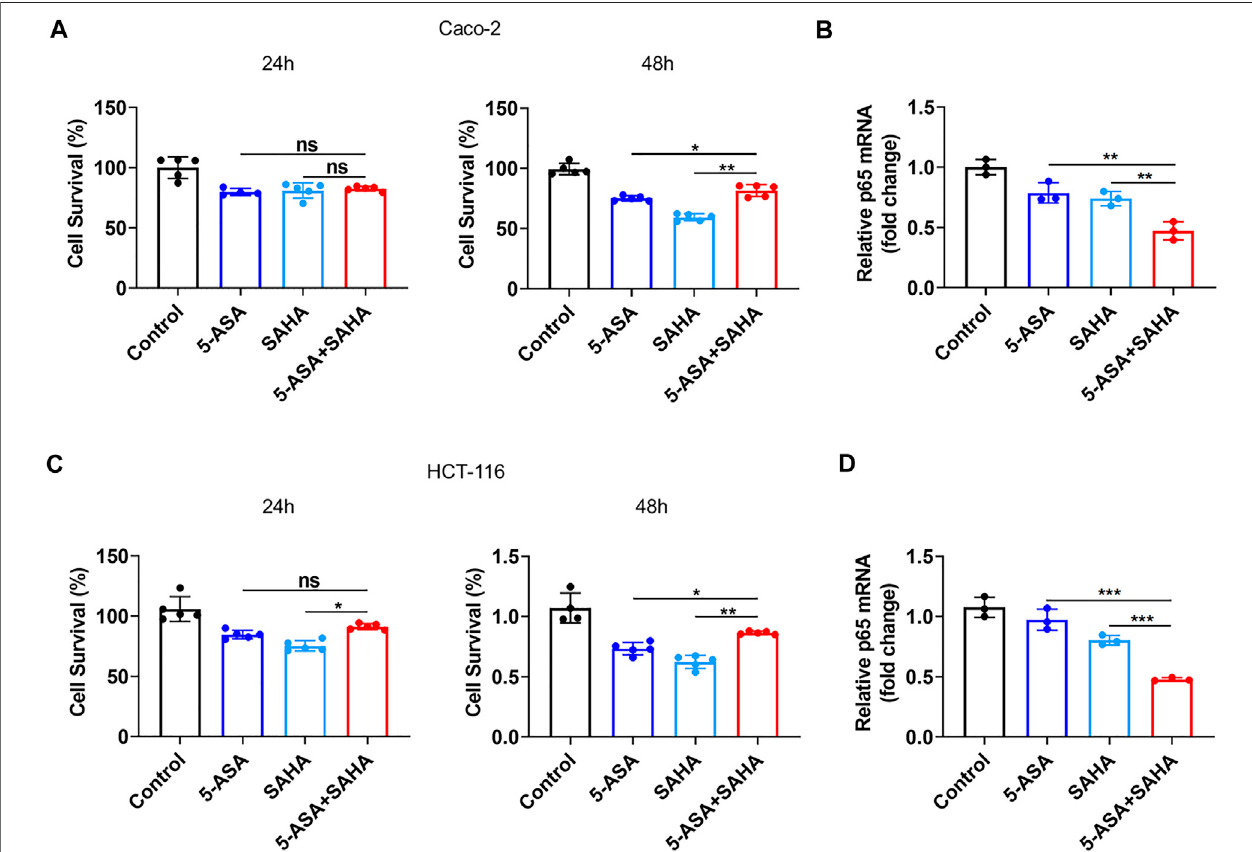
FIGURE3| Validationofthepredictionresults invivo . (A,C) CCKeightanalysiswasperformedtoevaluatethetoxicityof5-ASA(30 mM)andSAHA(5 µM)aloneor in combination in Caco-2 cells or HCT-116 cells after 24 and 48 h of treatment; (B,D) The p65 mRNA levels were examined in Caco-2 cells and HCT-116 cells treated with5-ASAandSAHAin.Thedatashownarethemean ± SDandrepresentthreeindependentexperiments, p valueswerecalculatedusinganunpaired t -test,* p < 0.05, ** p < 0.01, *** p < 0.001, ns (cid:1) not signi fi cant.